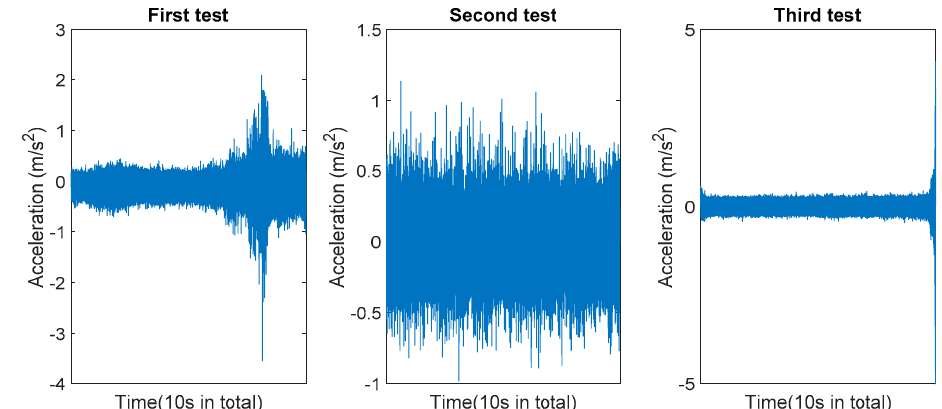
Figure 2. Recorded raw data from IMS bearing experimental platform.